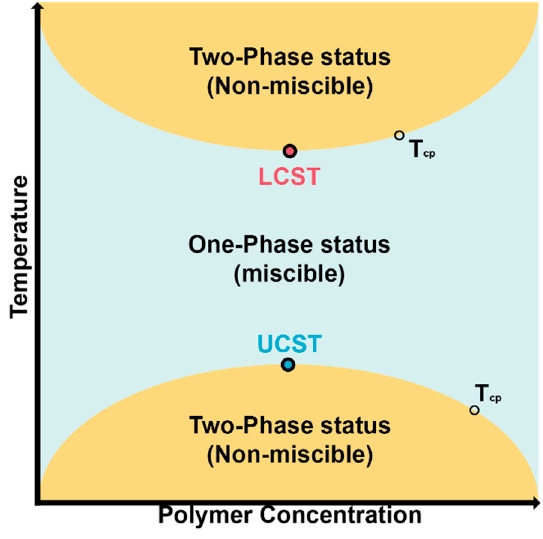
Figure 1. LCST and UCST of thermosensitive polymers. Table 1. Polymers with LCST that are commonly used in the biomedical